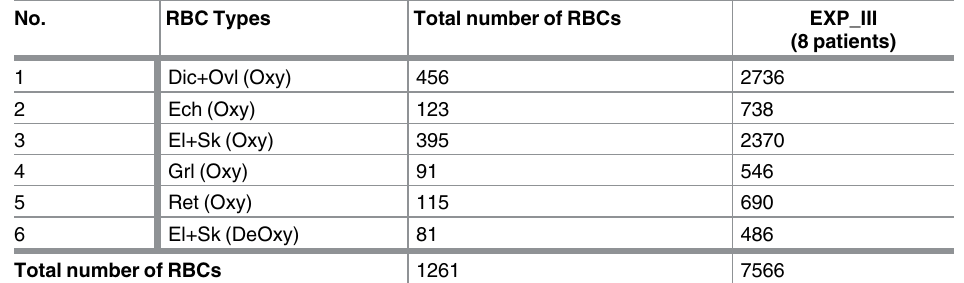
Table 5. Description of our experimental dataset for the coarse-labeled five categories and a new deoxygenated category (row 6).